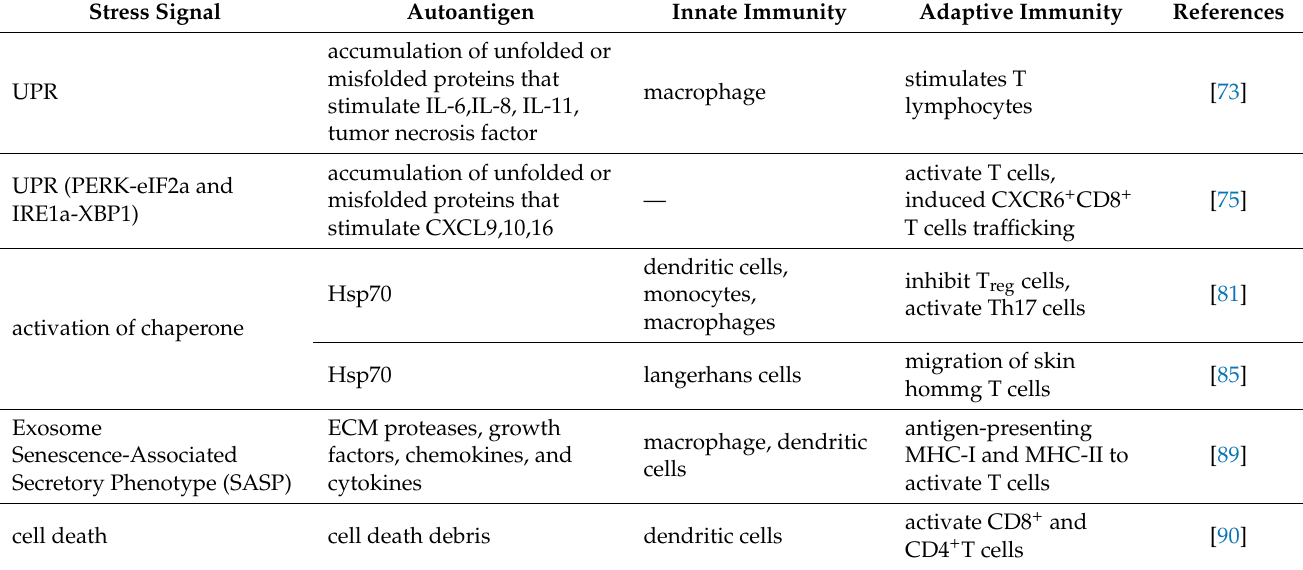
Table 1. Oxidative stress-induced autoantigen and